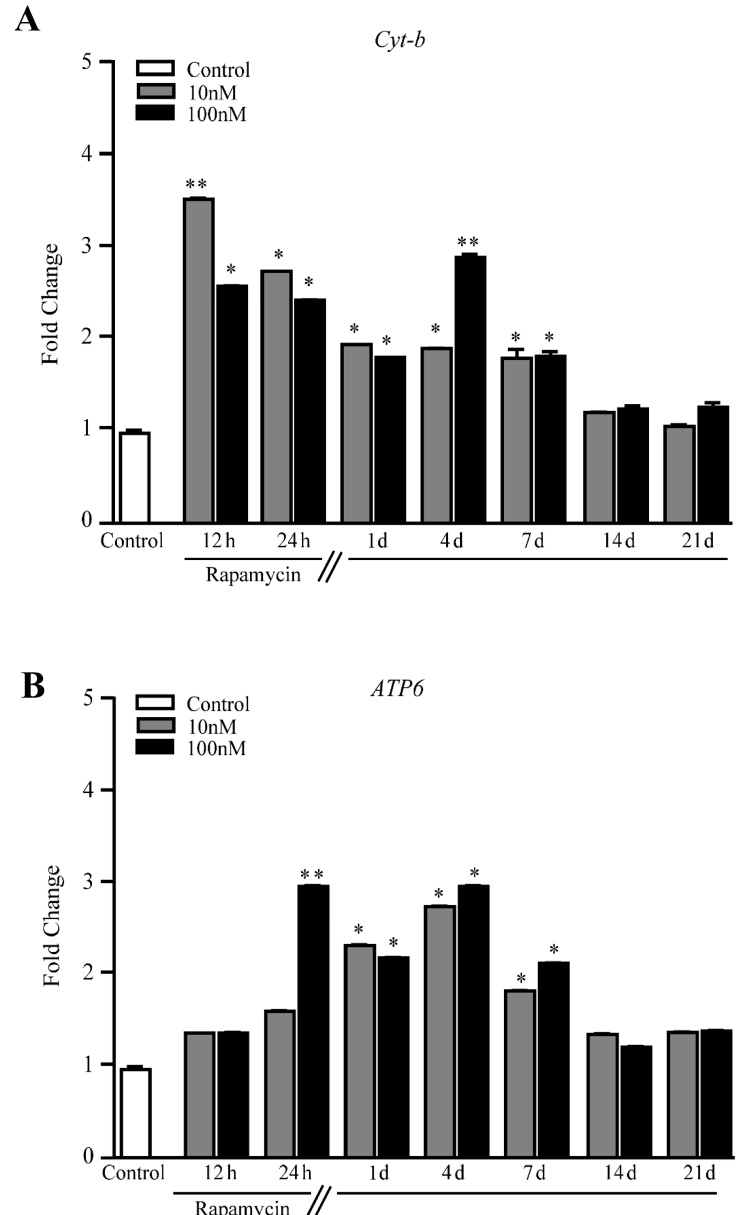
Figure 10. Rapamycin increases mRNA levels for constitutive mitochondrial genes within U87MG cells. RT PCR for ( A ) Cyt-b, and ( B ) ATP6 . * p ≤ 0.05 vs Control. The effects of rapamycin persist up to 7 d of rapamycin withdrawal. ** p ≤ 0.05 vs Control and 10 nM rapamycin. Each RT-PCR was performed in triplicate and confirmed in two independent experiments using both beta-globin and beta-actin as internal